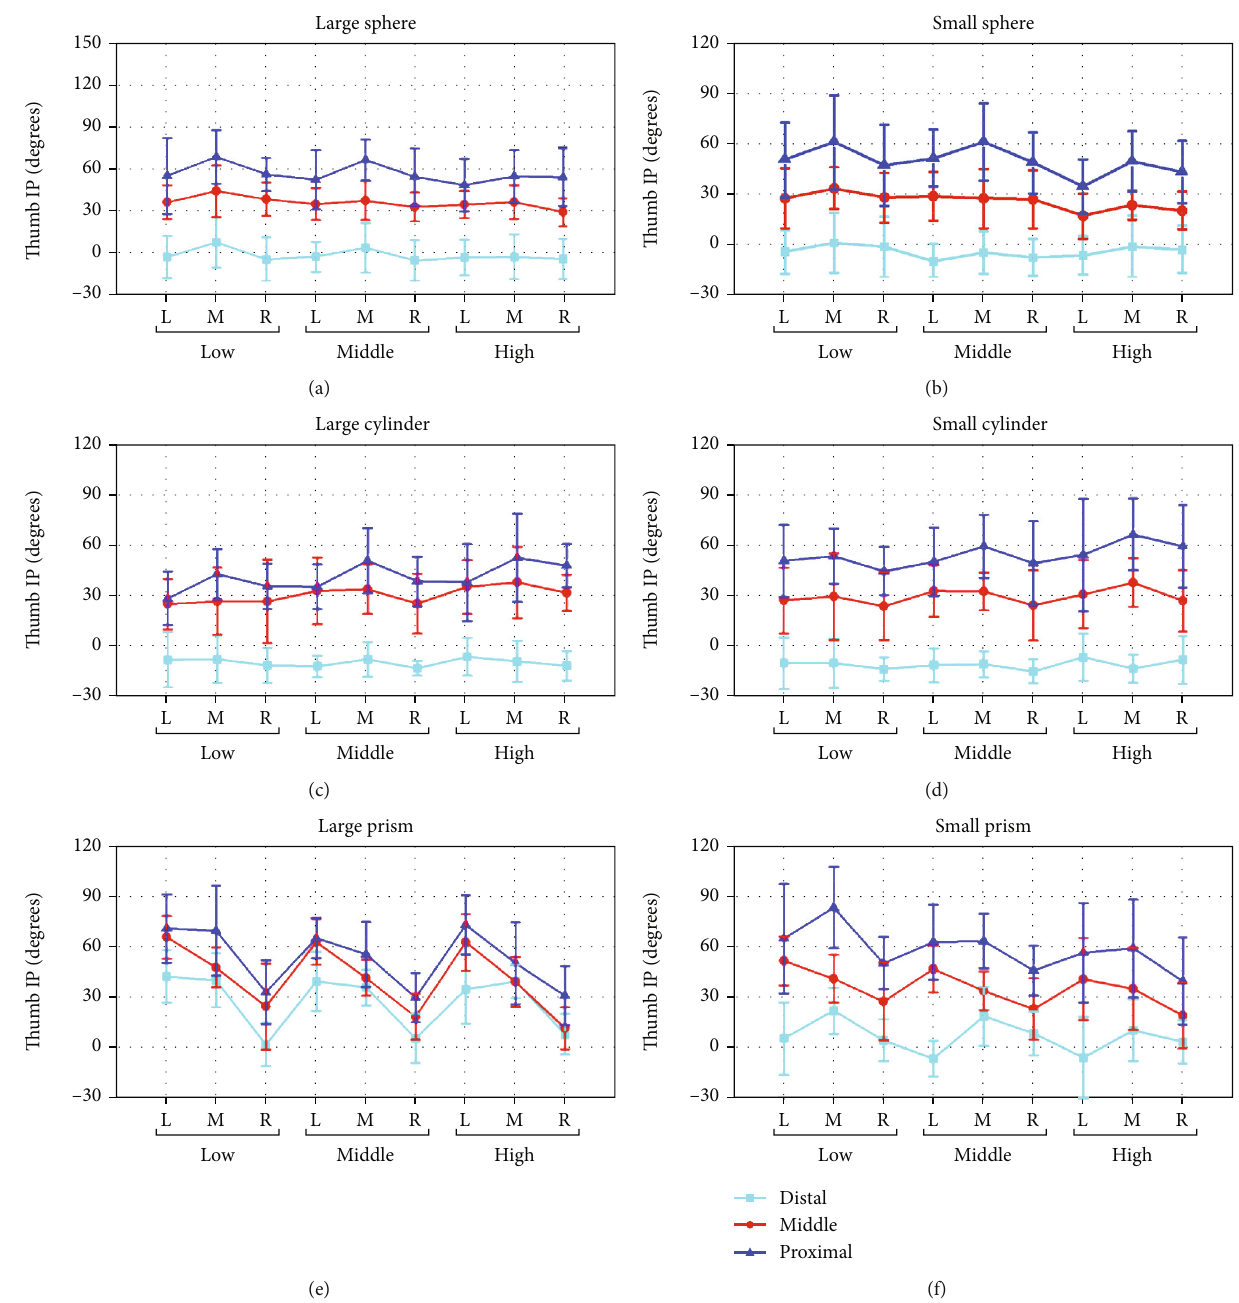
Figure 5: Thumb IP joint angle in fl uenced by the object shape, object size, X deviation, Y deviation, and Z deviation. L, M, and R represent the X deviation from left to right. Low, middle, and high represent the Z deviation from low to high. Distal, middle, and proximal represent the Y deviation from distal to